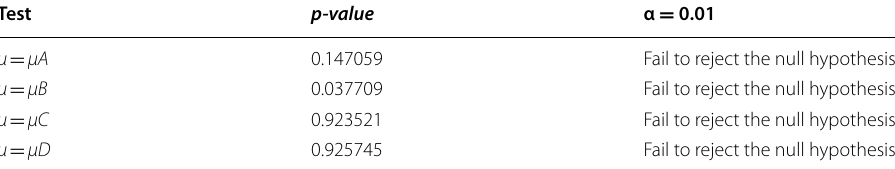
Table 9 Z test: Statistical coherence of the initial dataset with A , B , C and D Test